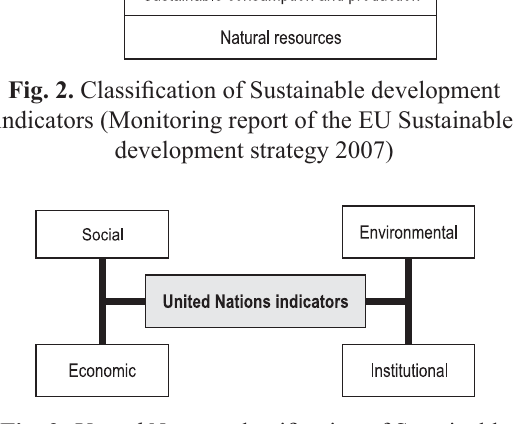
Fig. 3. United Nations classifi cation of Sustainable development indicators. Source: United Nations